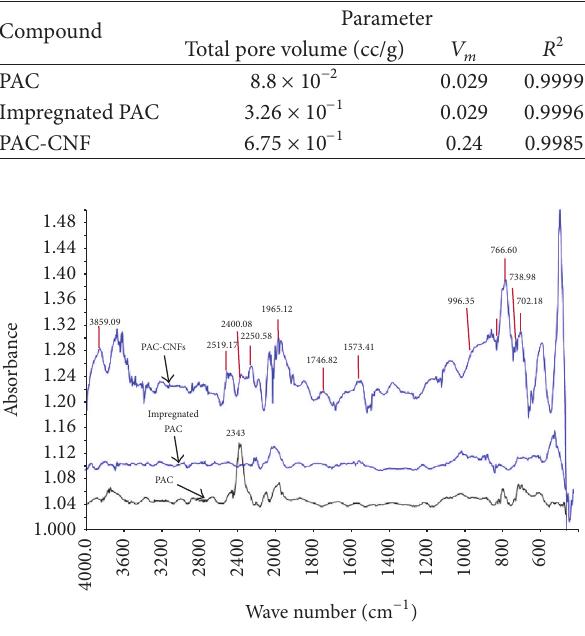
Figure 8: FTIR diagram of PAC, impregnated PAC, and